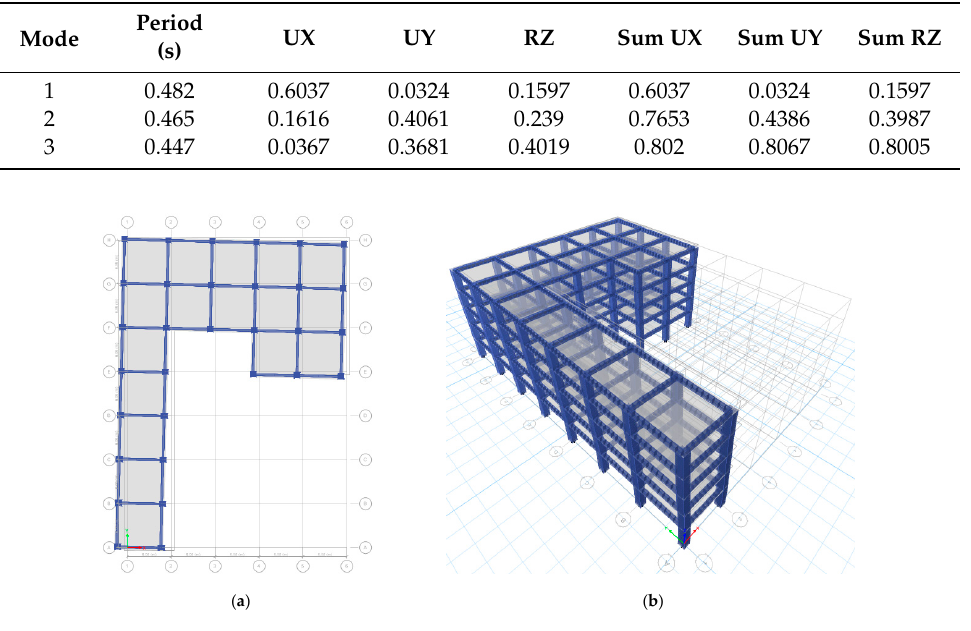
Figure 6. The 1st mode shape for T 1 = 0.482 s: ( a ) plane view, and ( b ) 3D view.